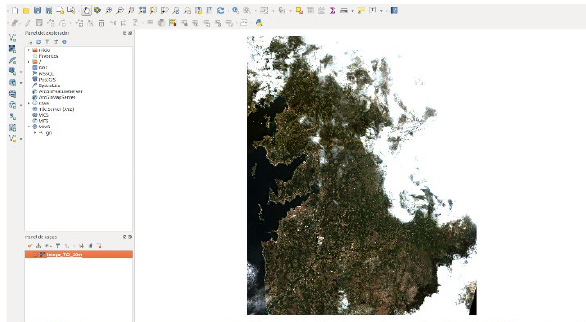
Figure 6 Visualization of the orthomosaic obtained through